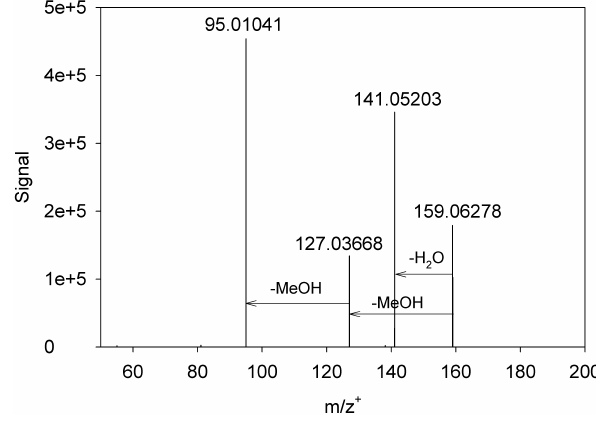
Figure 3. A full FTICR-MS spectrum for the standard solution of methylglyoxal (10mM) and tert -butyl hydroperoxide (10mM) in the positive mode.